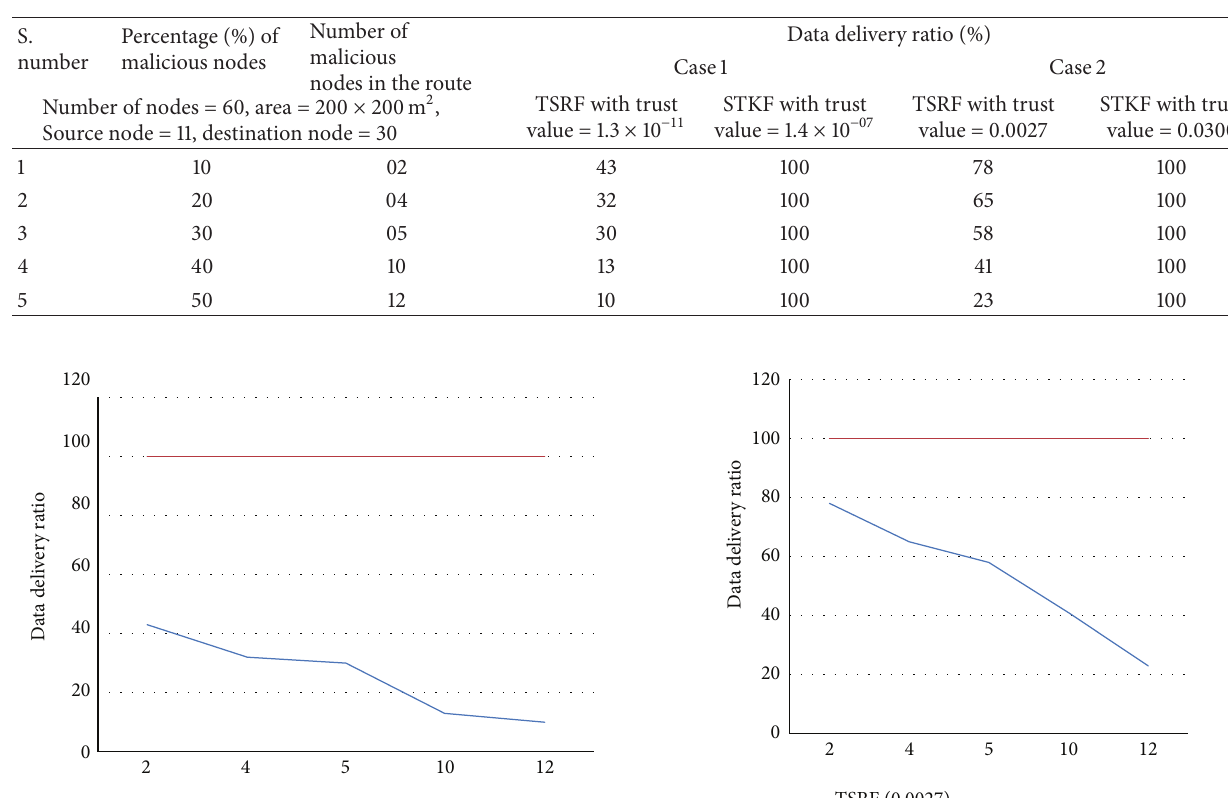
Table 3: Comparison of data delivery ratio with respect to percentage of malicious node.